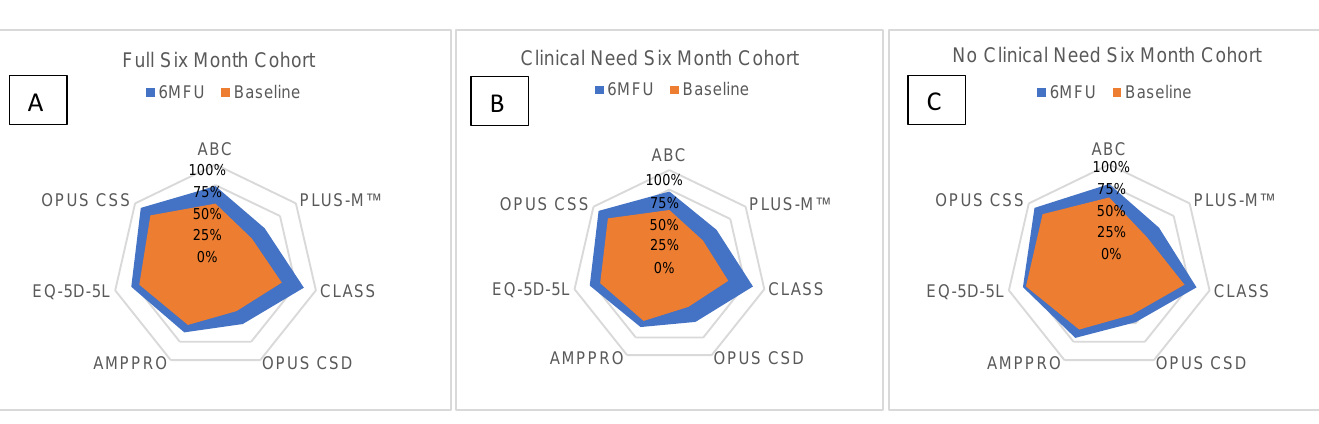
Figure 5: A: Illustrating changes (index value from 0-100%) in outcomes for all participants that completed the study from Baseline (Orange) to 6MFU (Blue) for all measures except TUG. B and C: Illustrating changes (measured on a scale from 0-100%) in outcomes for the "clinical need" sub-group and the "no clinical need" sub-group (5C), from Baseline (Orange) to 6MFU (Blue) for all measures except